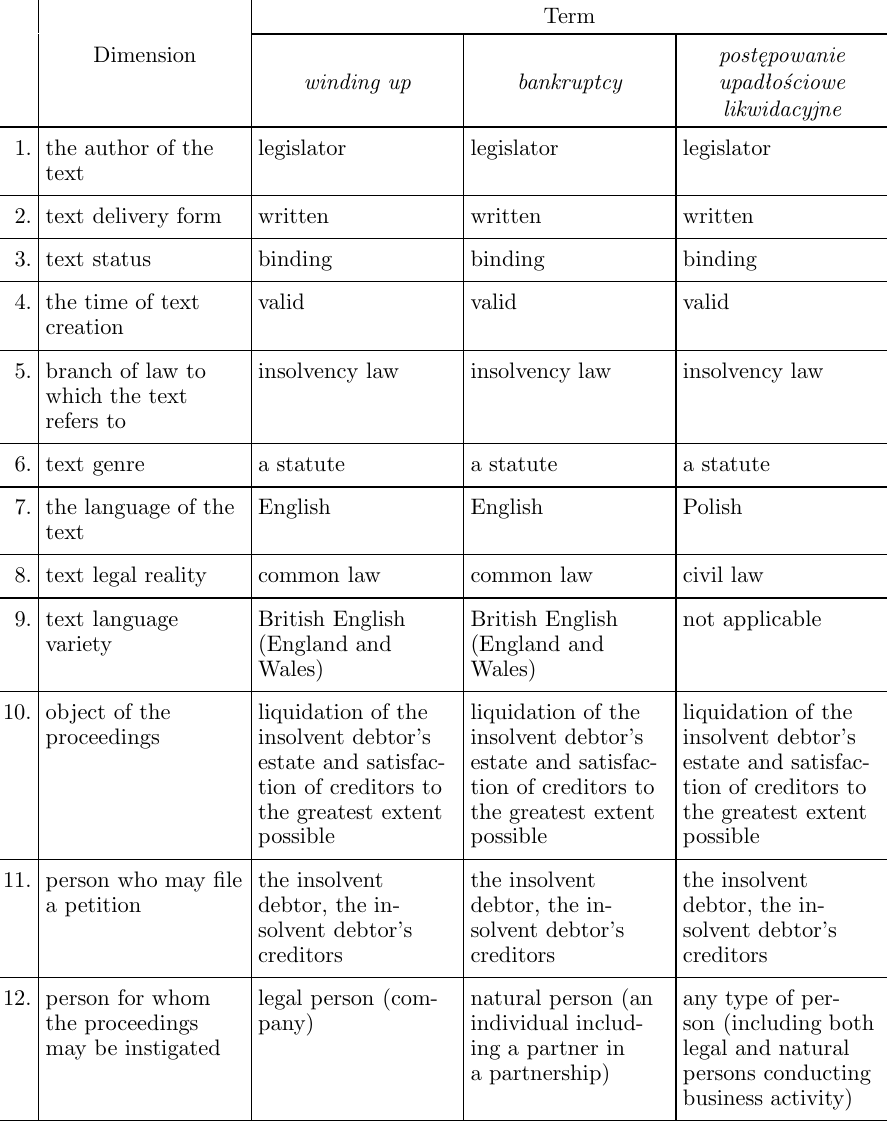
Parametrisation of the terms: winding up , bankruptcy and postępowanie upadłościowe likwidacyjne Term Dimension postępowanie winding